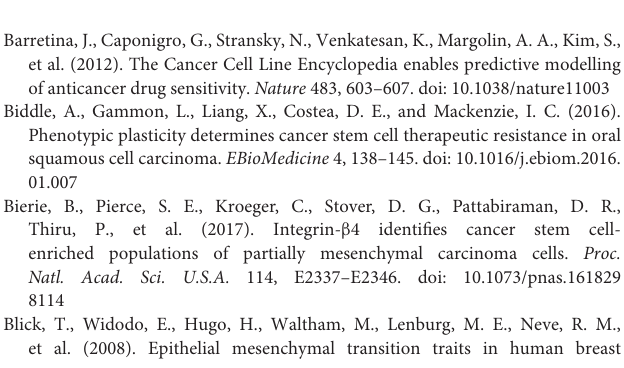
TABLE S5 | EMT score correlation in the list of 85 microarray GEO datasets. TABLE S6 | EMT scores in E, E/M and M categories of CCLE samples, as defined by MLR EMT scores. (A) Mean and standard deviation of EMT scores in E, E/M and M samples. (B) Correlation between EMT scores across E, E/M and M categories. TABLE S7 | Most variable and least variable tumor types based on the coefficient of variation of EMT scores. TABLE S8 | Pairwise correlation between all three EMT scores in subcategories (E, E/M, and M) across all tumor types of CCLE data. TABLE S9 | Abundance of hybrid E/M samples in different tumor